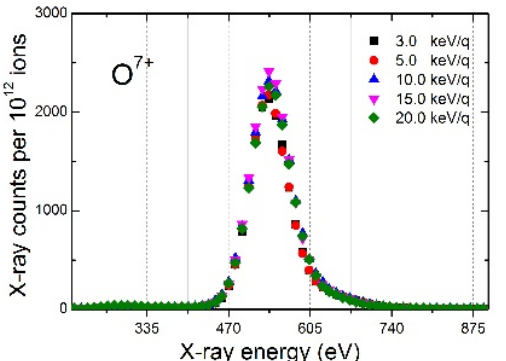
Figure 4. Measured X-ray spectra for O 7+ ions impinging on the Cu surface at projectile kinetic energies from 3.0 to 20.0 keV/q. The raw X-ray spectra have been normalized into intensity spectra in units per 10 12 ions.